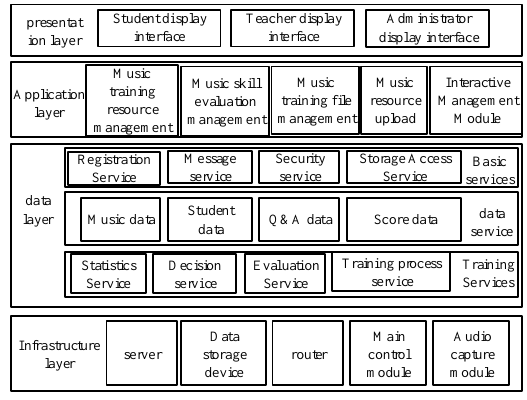
Figure 1. The overall structure of the system The music training assistant system based on artificial intelligence mainly includes four parts: infrastructure layer, data layer, application layer and presentation